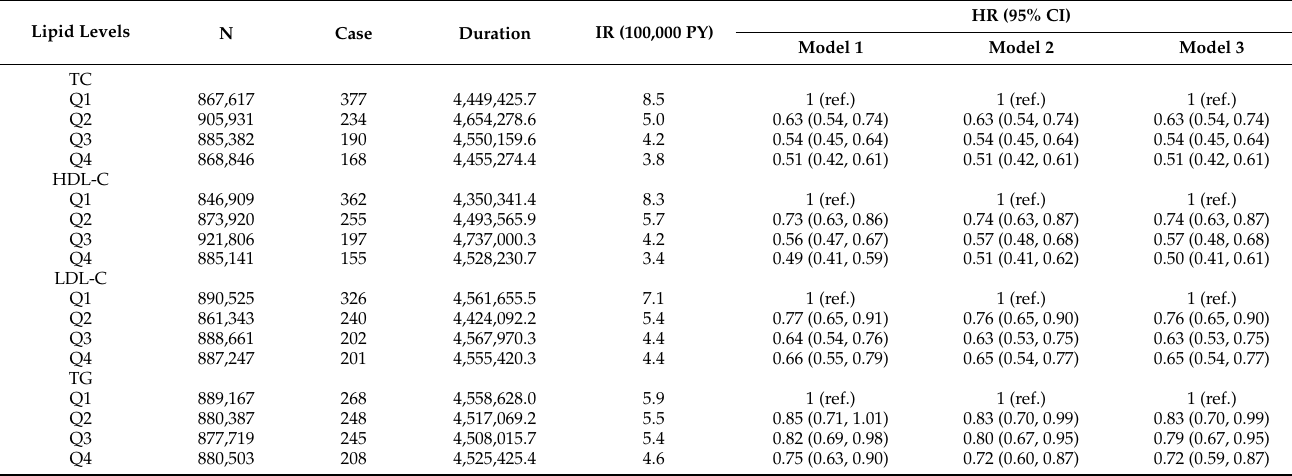
Table 2. Risk of Multiple Myeloma by quartiles of lipid levels at